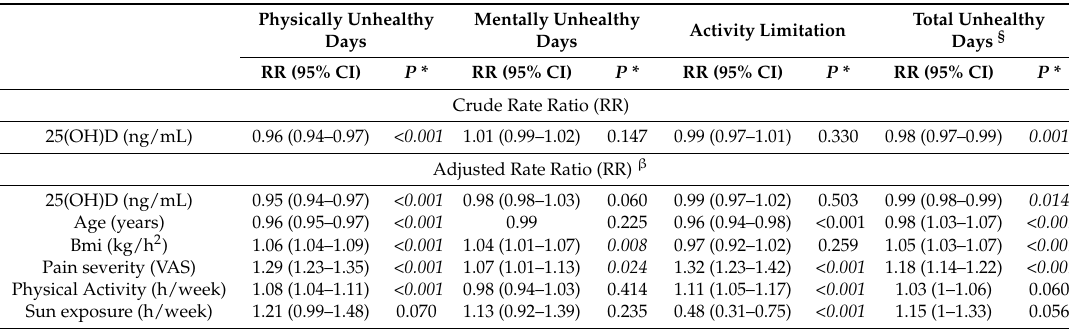
Table 4. The association between 25(OH)D (ng/mL) and unhealthy days. Physically Unhealthy Mentally Unhealthy Days